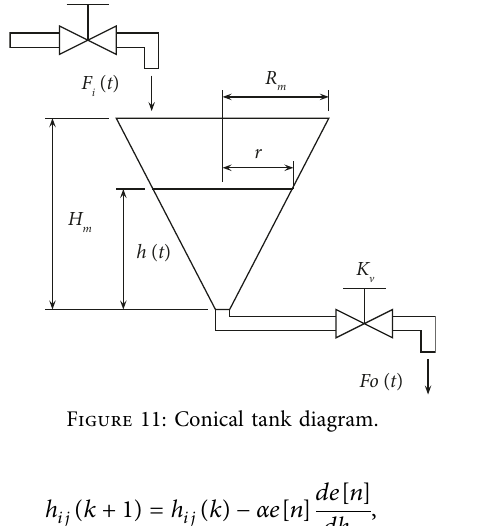
Figure 11: Conical tank